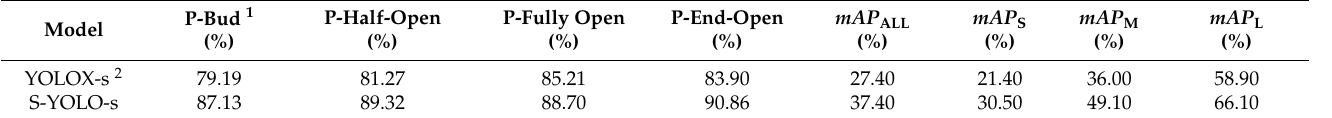
Table 6. Comparison of the effects of YOLOX-s and S-YOLO-s on flowering detection in